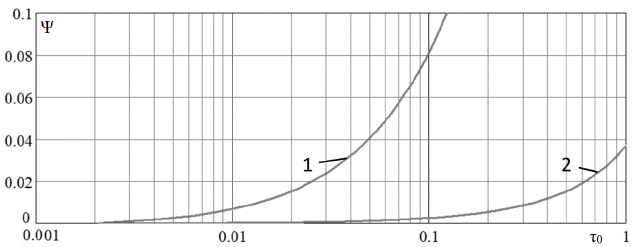
Figure 8. The function of the approximation error of numerical solutions of the test problem III based on the scheme (30) depending on the time step: 1—explicit scheme ( σ = 0), 2—scheme with weight σ =